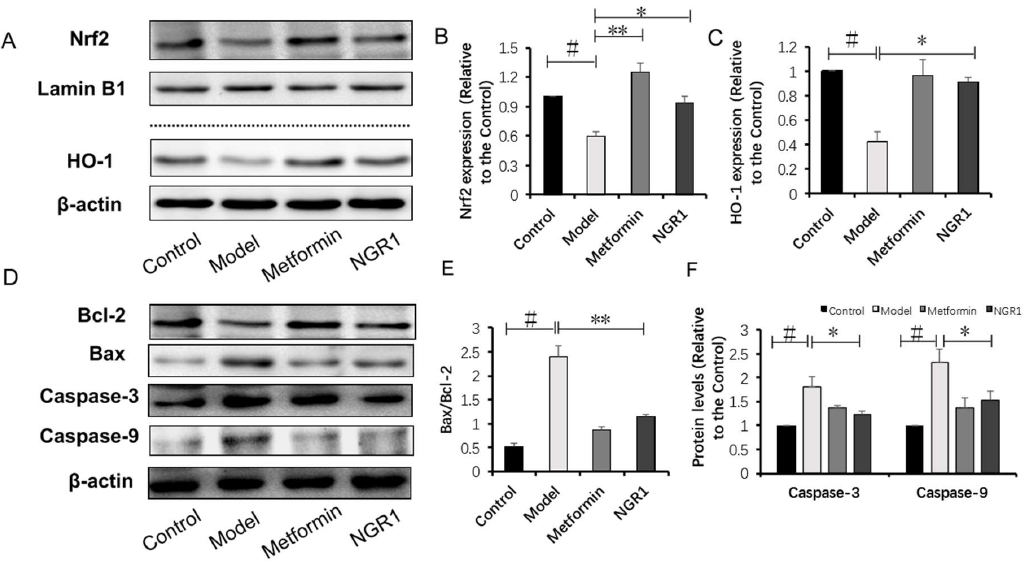
Figure 5. NGR1 inhibited apoptosis via upregulation of nuclear factor erythroid 2-related factor 2 (Nrf2)-mediated heme oxygenase-1 (HO-1) expression in db/db mice. ( A ) Representative images of nuclear Nrf2 and HO-1 protein expression determined by Western blot; ( B , C ) relative protein expressions of nuclear Nrf2 to Lamin B1, and HO-1 to β-actin are expressed in the bar graphs; ( D ) representative images of apoptotic protein immunoblots and ( E , F ) immunoblotting results quantified in the bar graphs. All data are presented as the mean ± SD ( n = 3). # p < 0.05 vs. the control group; * p < 0.05 or ** p < 0.01 vs. the model group.